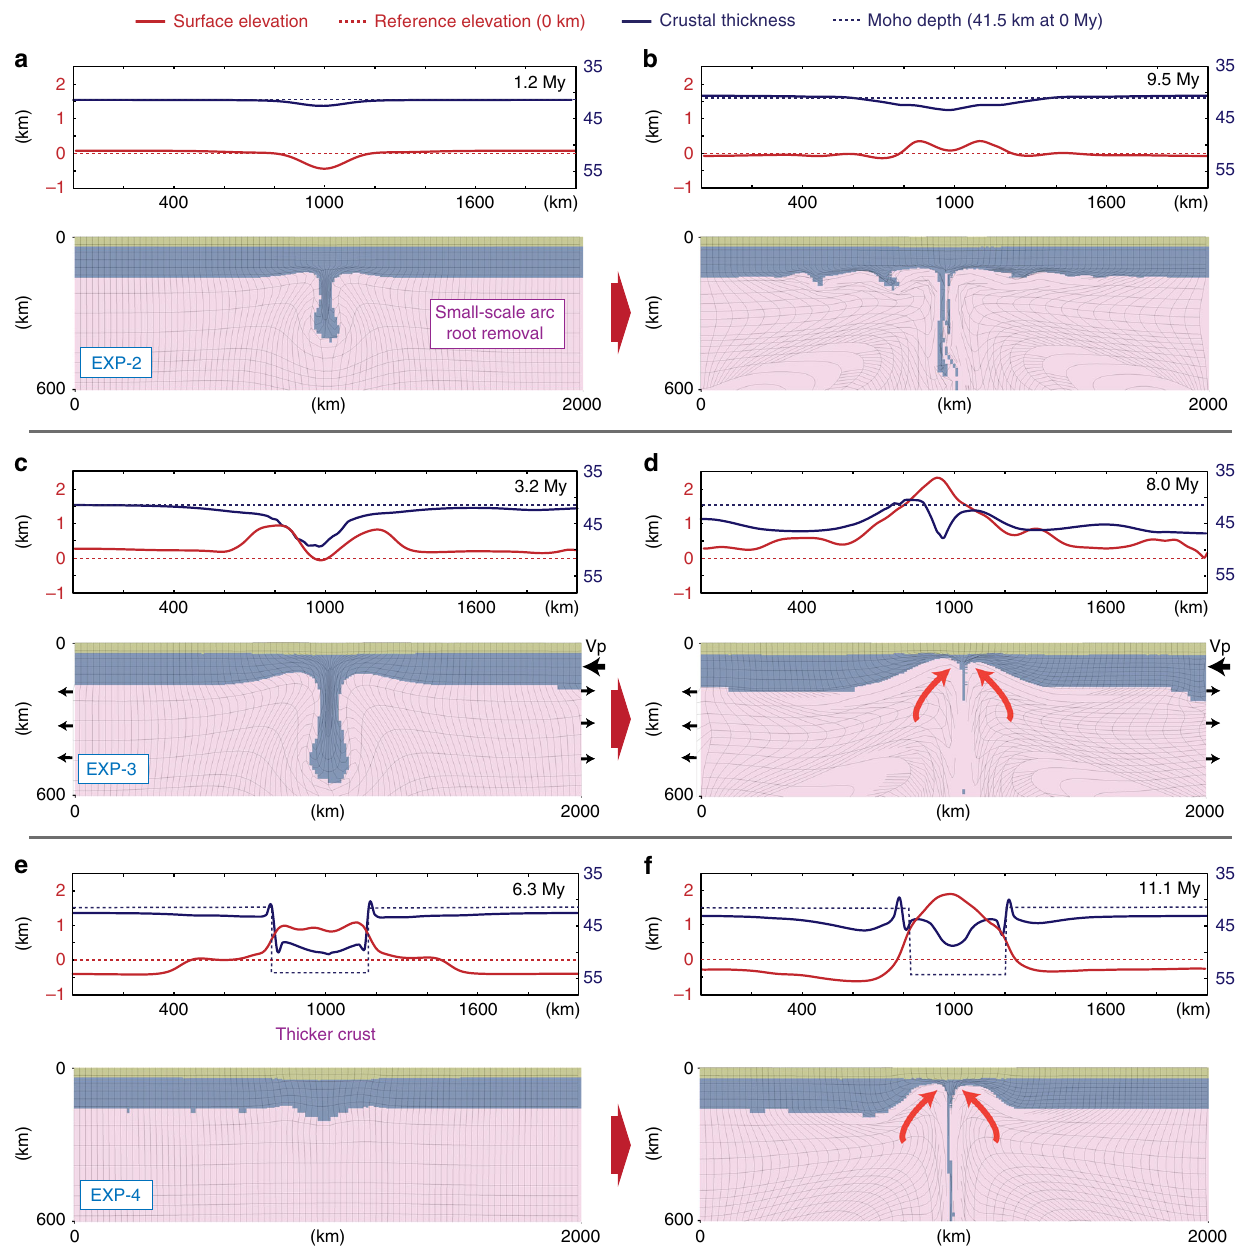
Fig. 3 Model predictions of alternative lithospheric drip experiments. Model results as in Fig. 2 for models: a , b EXP-2 with temperature dependent and dry olivine creep law mantle lithosphere rheology 34 ; c , d EXP-3 with imposed lithospheric convergence velocity of 2 cm/year, approximations to the orogenic shortening and lithospheric drip operating simultaneously 35 ; e , f EXP-4 with locally increased crustal thickness of 55 km, testing the crustal response to the gravitational collapse and the lithospheric drip 37 . There is slight asymmetric development in the crustal thickness pro fi le due to the imposed plate convergence velocity to the lithospheric